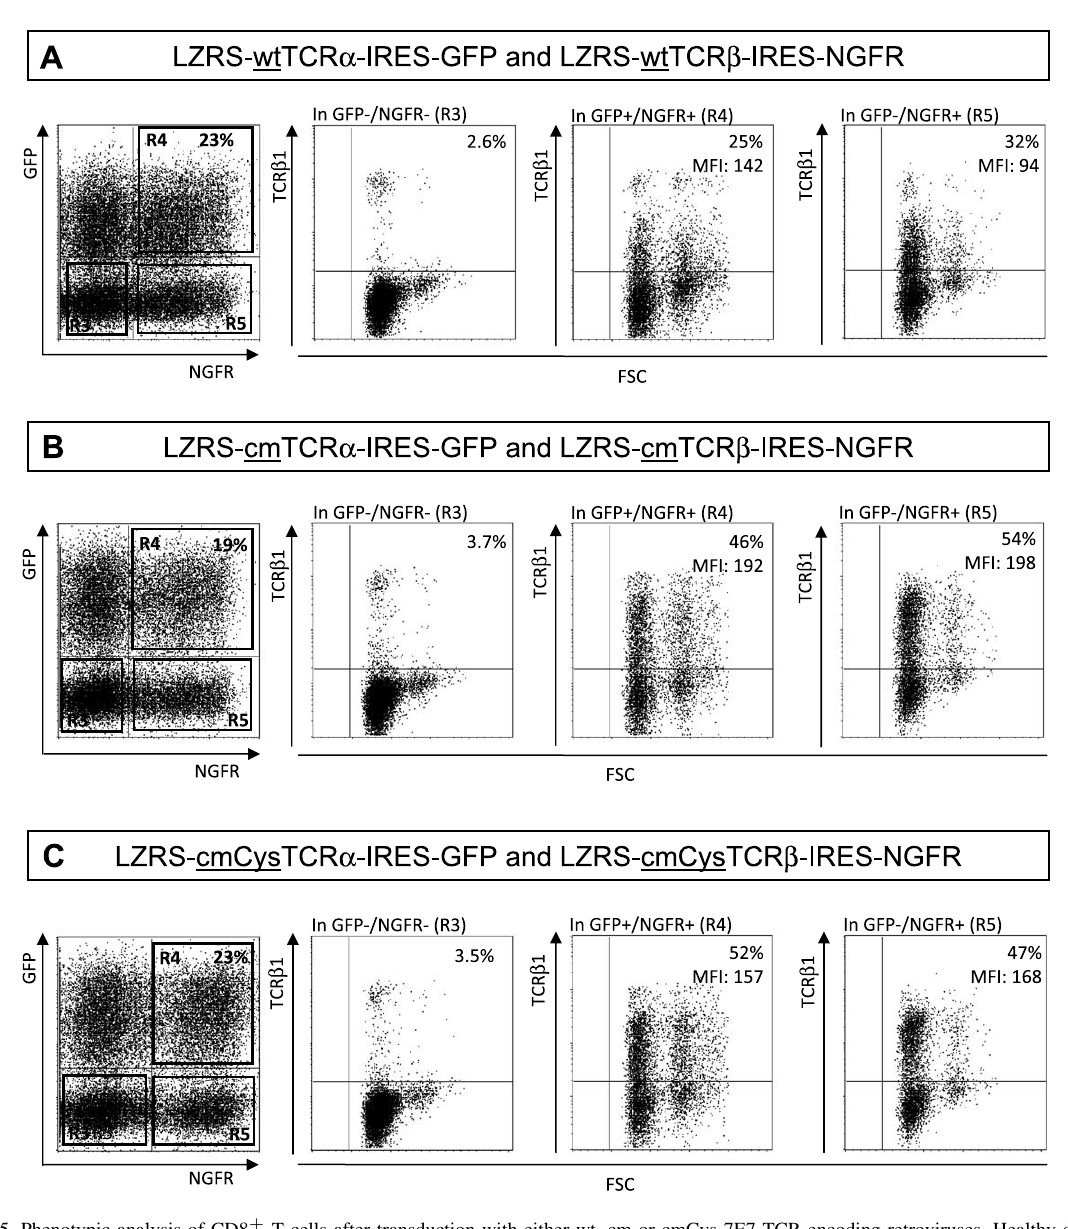
Fig. 5. Phenotypic analysis of CD8 + T cells after transduction with either wt, cm or cmCys 7E7-TCR encoding retroviruses. Healthy donor derived CD8 + T cells were transduced with TCR α -I-GFP and TCR β -I-NGFR encoding retroviruses. TCRV β 1 analysis was performed on T cells with the wt (A), cm (B) or cmCys (C) 7E7-TCR in gate R3 (GFP − /NGFR − ), gate R4 (GFP + /NGFR + ) or gate R5 (GFP − /NGFR + ). Data are representative for 4 different donors